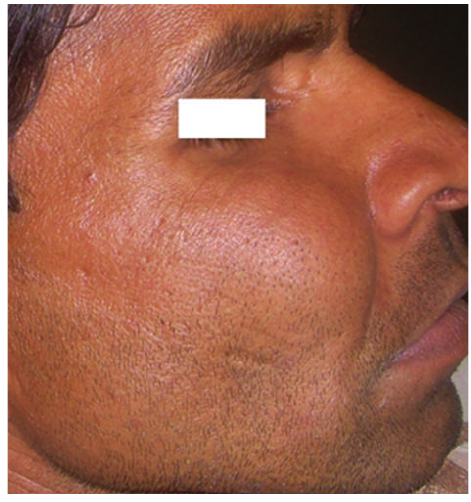
Figure 1: A golf-ball-sized swelling on the right maxilla causing facial asymmetry. Figure 2: Anteroposterior extension of the swelling.